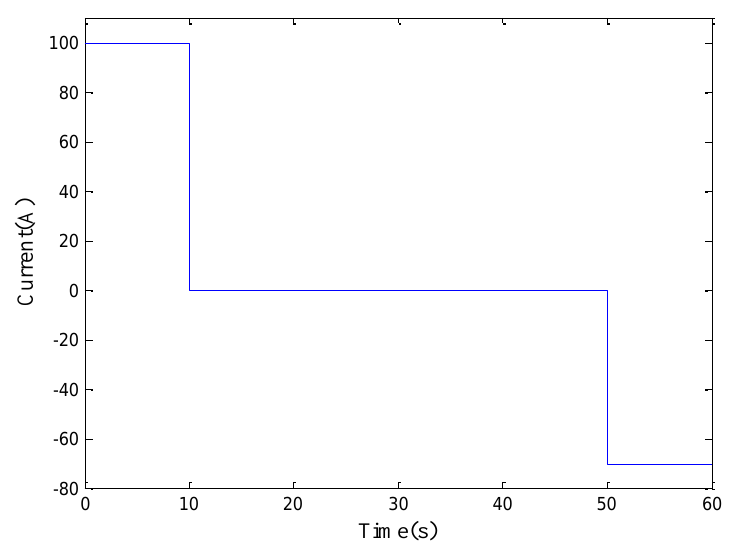
Figure 3. A single HPPC test profile.